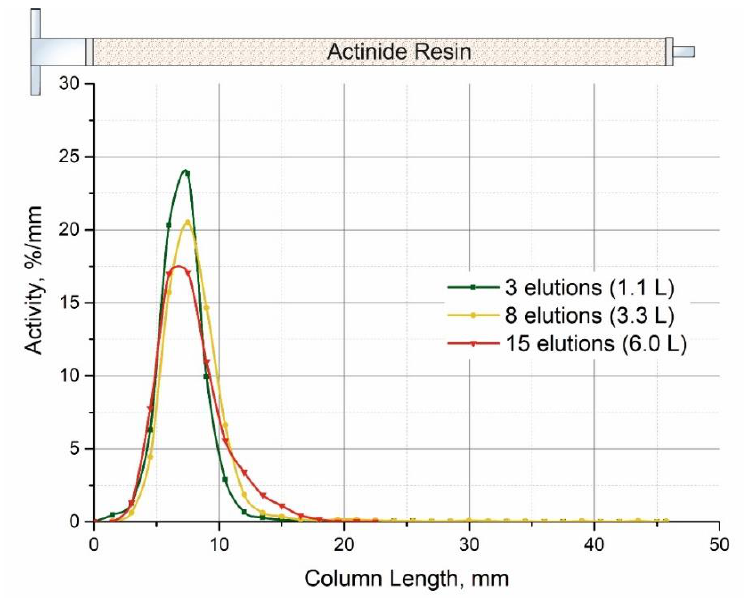
Figure 11. Distribution of activity along with the length of Actinide Resin column (0.4 mL) in the generator “Afrabis” depending on the number of elutions or the total volume of 0.25 M nitric passed through the column.